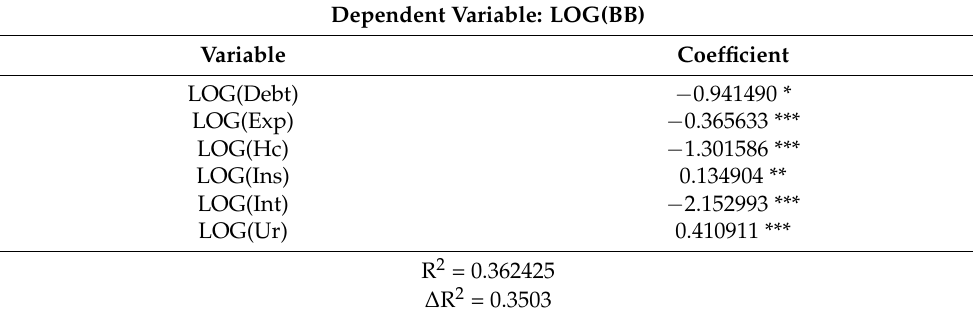
Table 8. Outcomes after the